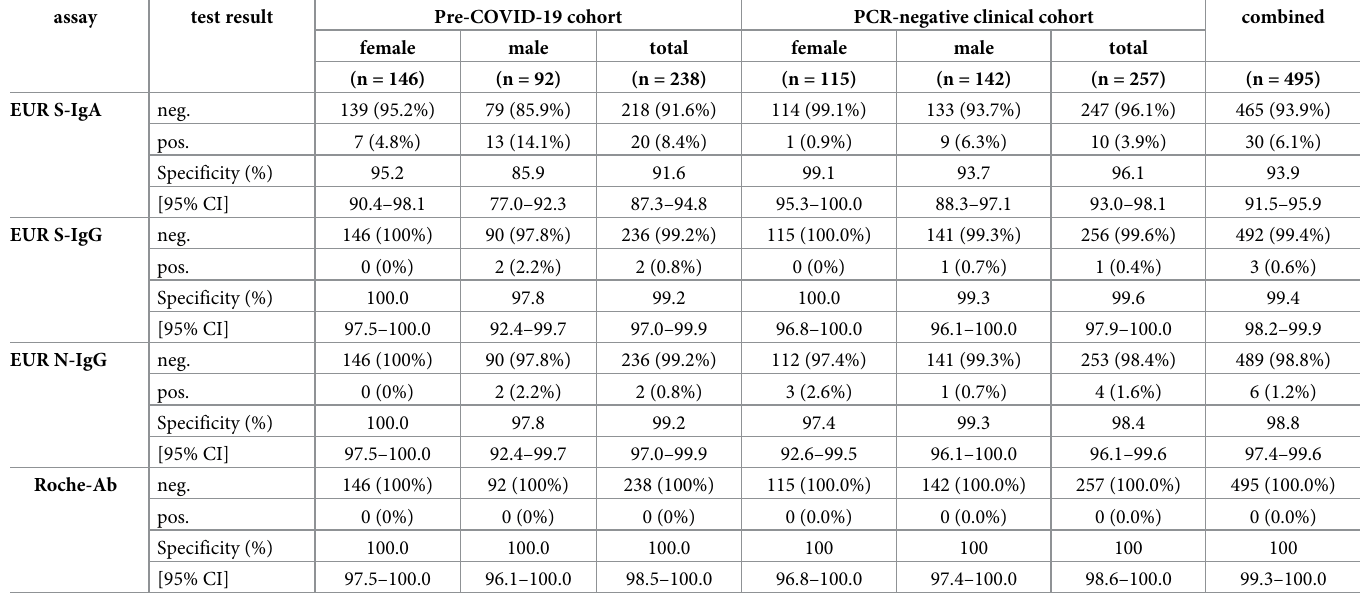
Table 2. Antibody reactivity and specificity of the four immunoassays in two negative cohorts. assay test